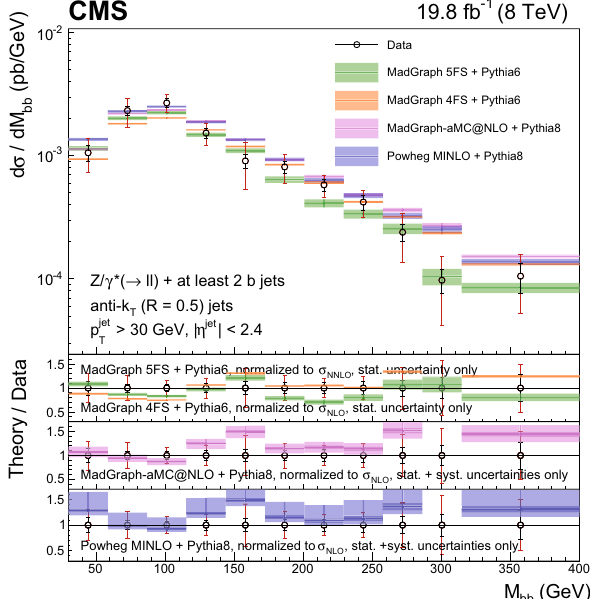
Fig. 11 Differential fiducial cross section for Z(2b) production as a function of the Z boson p T , compared with the MadGraph 5FS, Mad- Graph 4FS, MadGraph5 _a MC@NLO , and powheg minlo theoreti- cal predictions ( shaded bands ), normalized to the theoretical cross sec- tions described in the text. For each data point the statistical and the total (sum in quadrature of statistical and systematic) uncertainties are represented by the double error bar . The width of the shaded bands represents the uncertainty in the theoretical predictions, and, for NLO calculations, theoretical systematic uncertainties are added in the ratio plots with the inner darker area representing the statistical component only